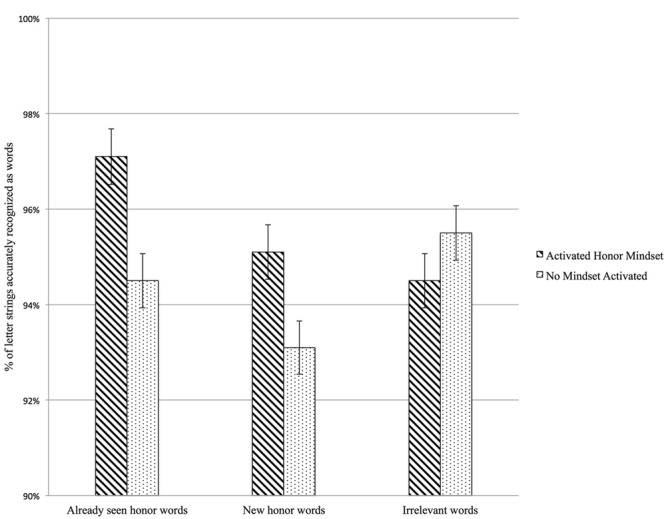
Study 2: The effect of activating an honor mindset on percentage of letter-strings accurately recognized as words for honor-relevant words. Already seen = words present in the honor scale, new = words not present in the honor scale, irrelevant = honor-irrelevant words. Error bars represent standard errors. Analyses include handedness and accuracy at recognizing non-words as controls.